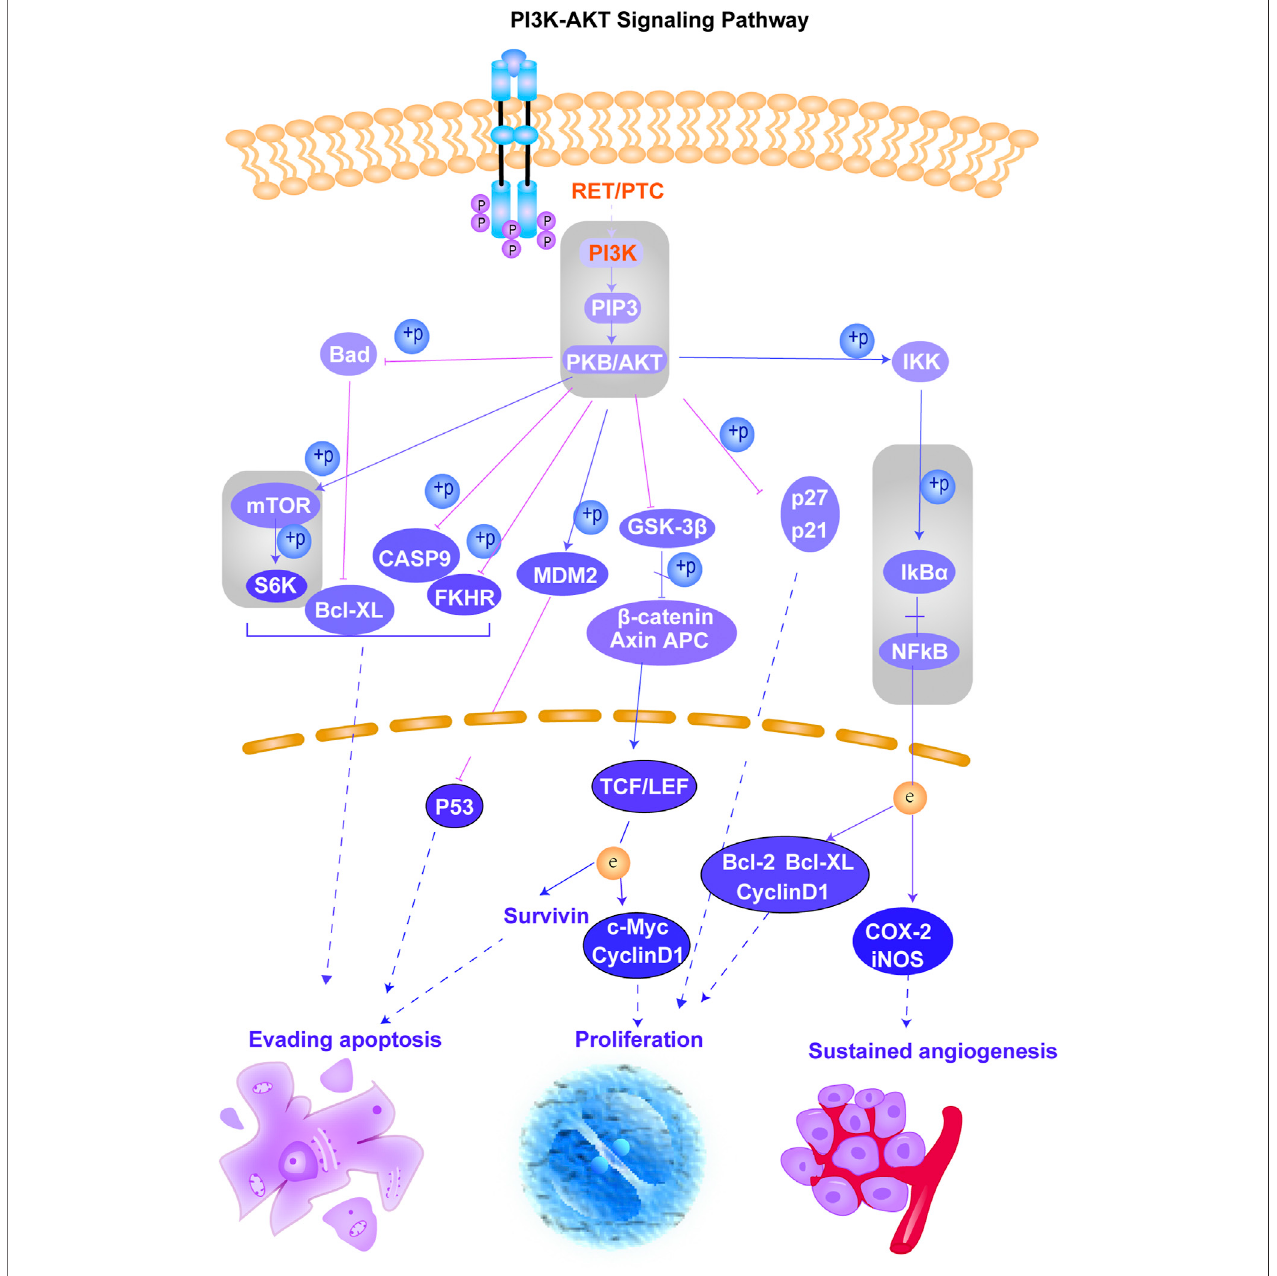
FIGURE 2 | Schematic of the PI3K – AKT signaling pathway. This fi gure shows the important cascades associated with the PI3K – AKT signaling pathway that involves in cell angiogenesis, proliferation, and apoptosis. The proteins marked in red represent the potential targets of erianin predicted in this study. The reported signaling pathways involved in anticancer mechanisms of erianin are framed in